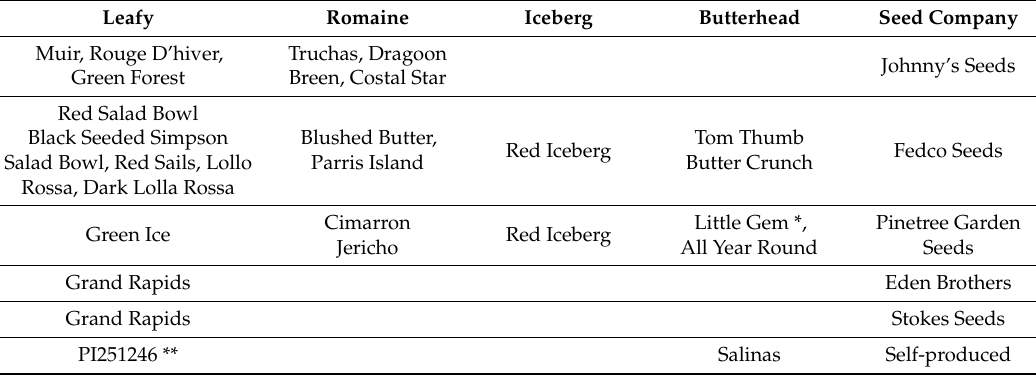
Table 1. Information on the 27 lettuce varieties used in this